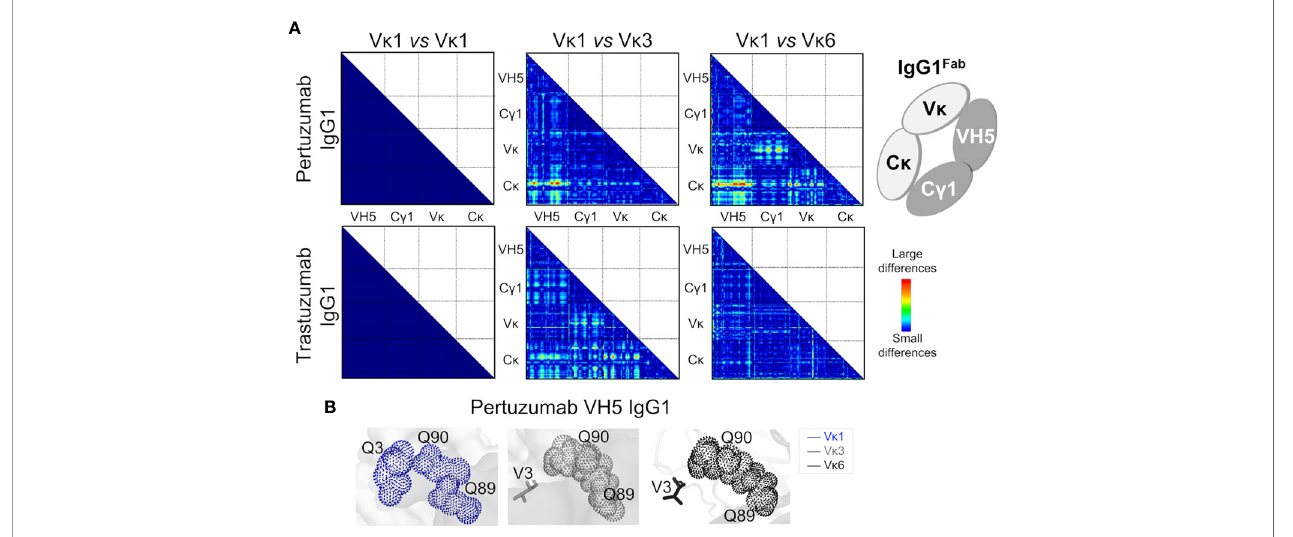
FIGURE 5 | Effects of the different VH5-V k pairings in the Pertuzumab and Trastuzumab IgG1 variants. (A) Distance-based difference maps [generated using CMView (49)] between Fab domains of Pertuzumab and Trastuzumab VH5-V k 3 and VH5-V k 6 IgG1 variants (superimposed against the respective VH5-V k 1 IgG1 as the reference) indicates more disruption by the V k 3 or V k 6 for Pertuzumab VH5 IgG1 variants, leading to varying changes in the heavy and light chain pairing. (B) An alternative Ni-NTA binding region in Pertuzumab VH5-V k 1 IgG1 formed a Q-stretch of V k 1 Q3, Q89, and Q90. These Q-stretches were incomplete due to the V k mutation Q3V in the Pertuzumab VH5-V k 3 and VH5-V k 6 IgG1